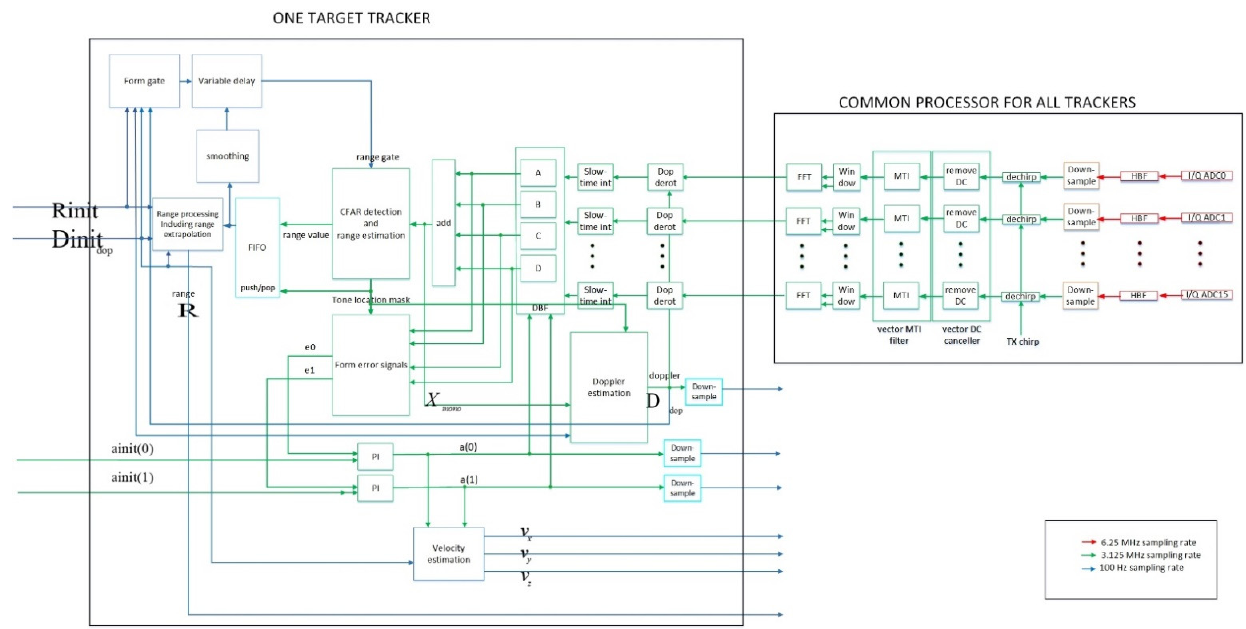
Figure 5. The receiver block diagram. HBF, DBF, PI, FIFO and CFAR stand for half-band filter, digital beamforming, proportional–integral, first-in-first-out and constant false alarm rate, respectively. The quantities e 0 and e 1 are monopulse tracking error signals for 𝑎(0) and 𝑎(1) . Please refer to [27] for some of the mathematical details of these blocks. The Doppler tracking loop (from “Dop derot” to “Slow-time int” to “DBF” to “add”